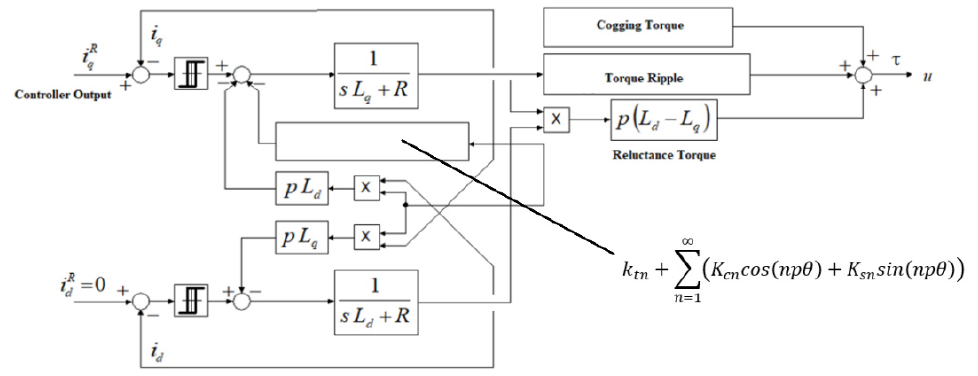
Figure 2. The block diagram of the torque input has an actuator dynamics